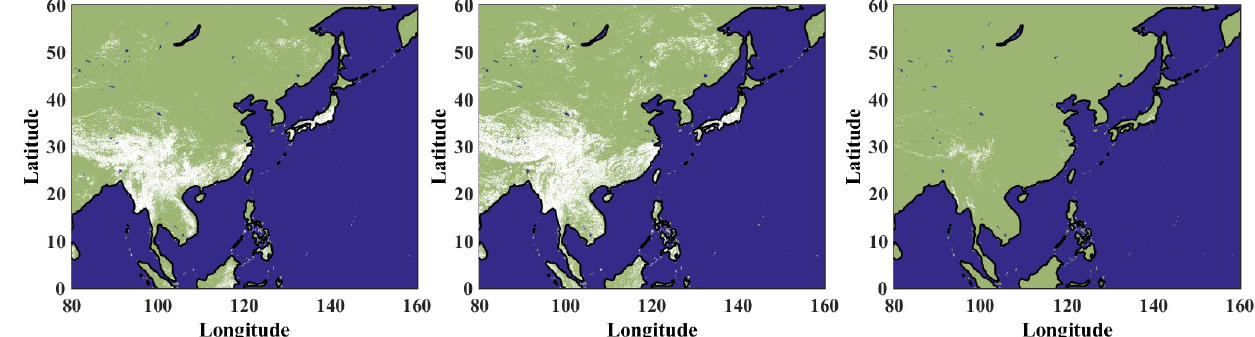
Figure 2. Synthesis of AHI observation of clear sky areas in latitude 0–60, longitude 80–160, and the white points are the pixel with clouds during the 16-day synthetic period of observation: ( left ) syn- thesis with 10:00 a.m. local observation time only; ( mid ) synthesis with 2:00 p.m. local observation time only; ( right ) synthesis of all observation moments throughout the day.